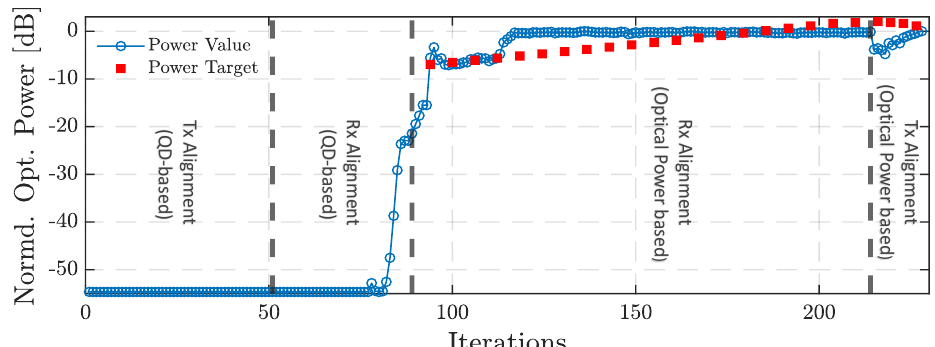
Figure 10. Optical power variation during the bidirectional alignment.